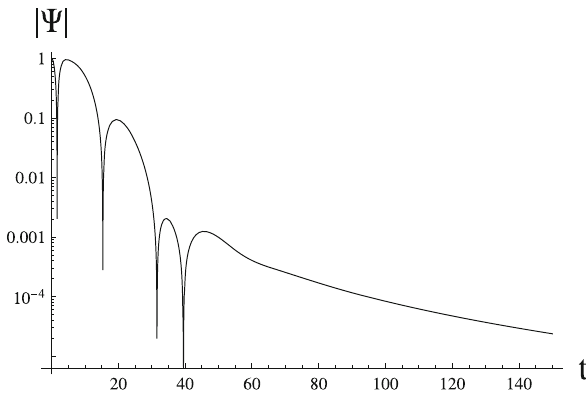
Fig. 5 Time-domain profile for vector type of gravitational perturba- tions (cid:11) = 5, α = 0 . 45, M = 1 /